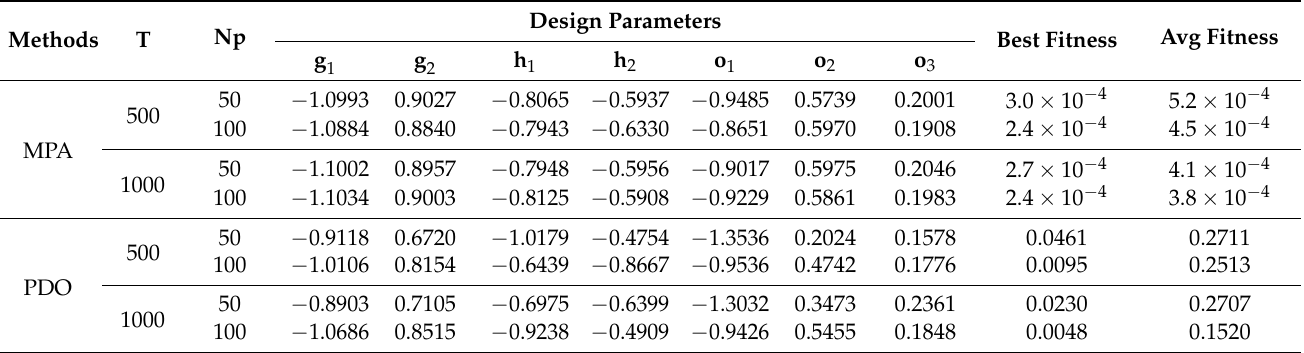
Table 5. Estimated weight analysis w.r.t generation and population sizes at 30 dB noise for case study